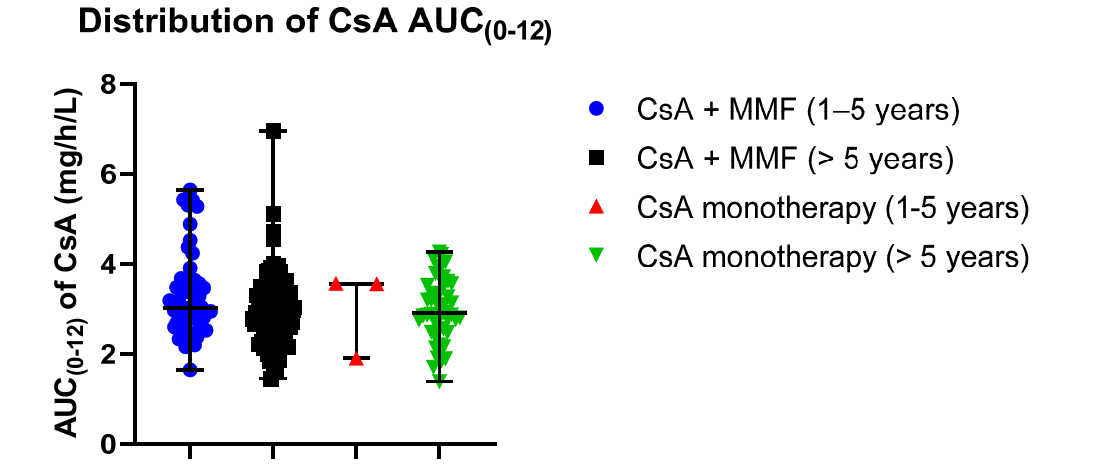
Figure 6. Distribution of CsA C 0 values in the study groups: CsA + MMF and CsA monotherapy; MMF—mycophenolate mofetil; CsA—cyclosporine. Scatter plots display the individual C 0 values’